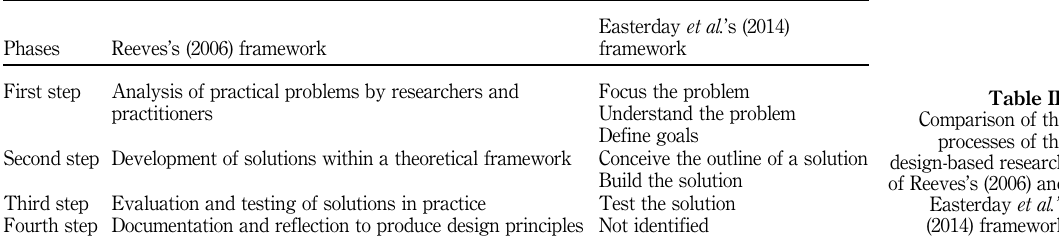
Table II. Comparison of the processes of the design-based research of Reeves ’ s (2006) and Easterday et al. ’